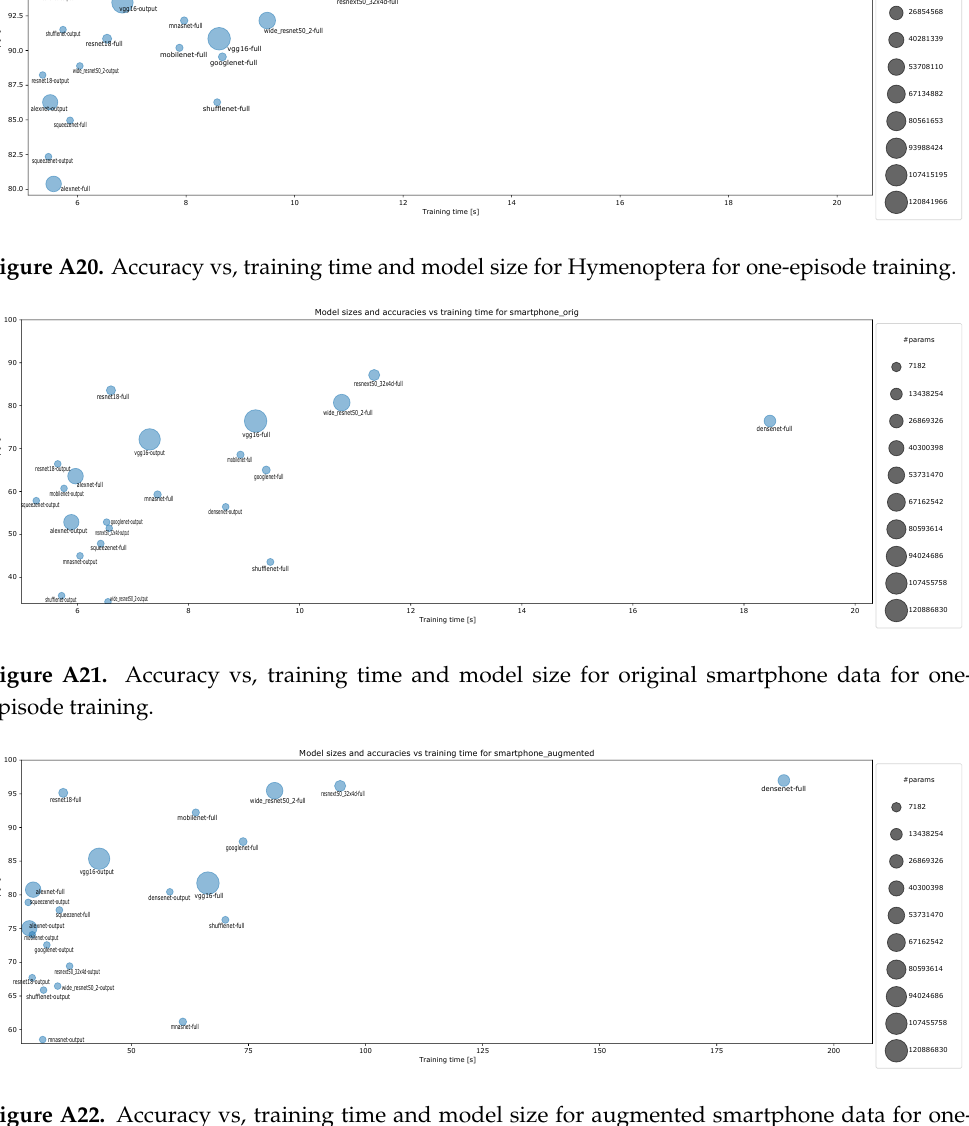
Figure A22. Accuracy vs, training time and model size for augmented smartphone data for one- episode